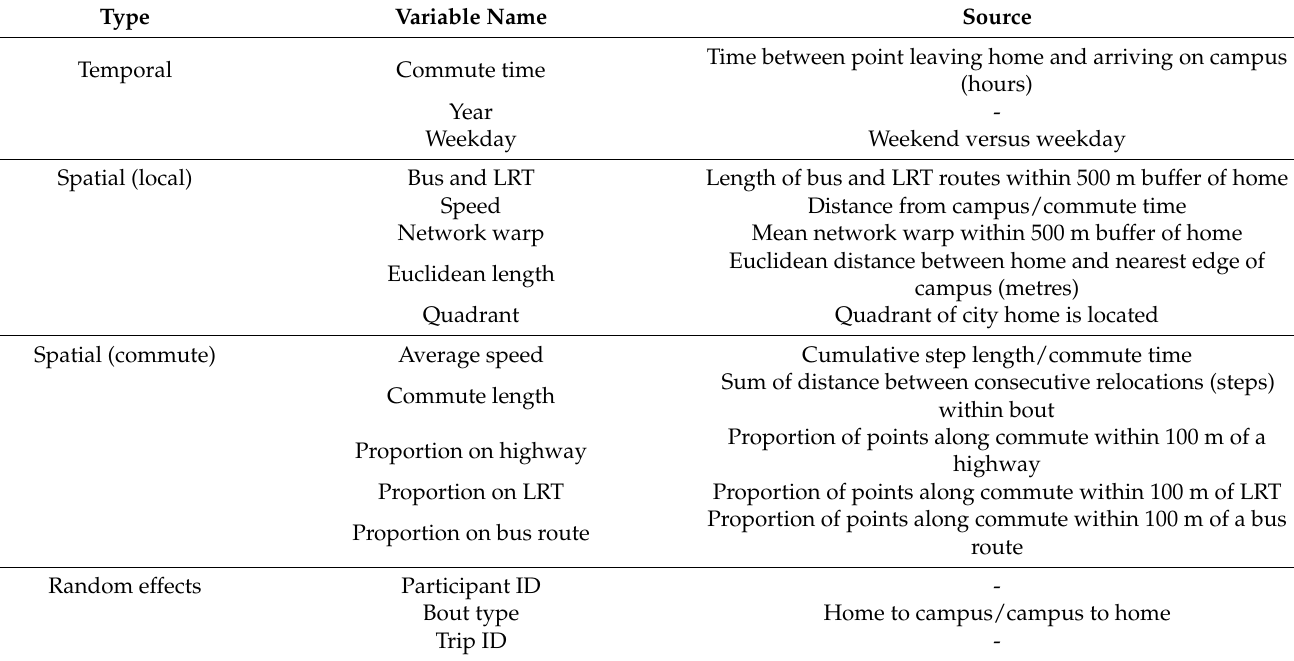
Table 1. Covariates predicted to influence commuting students’ time spent on